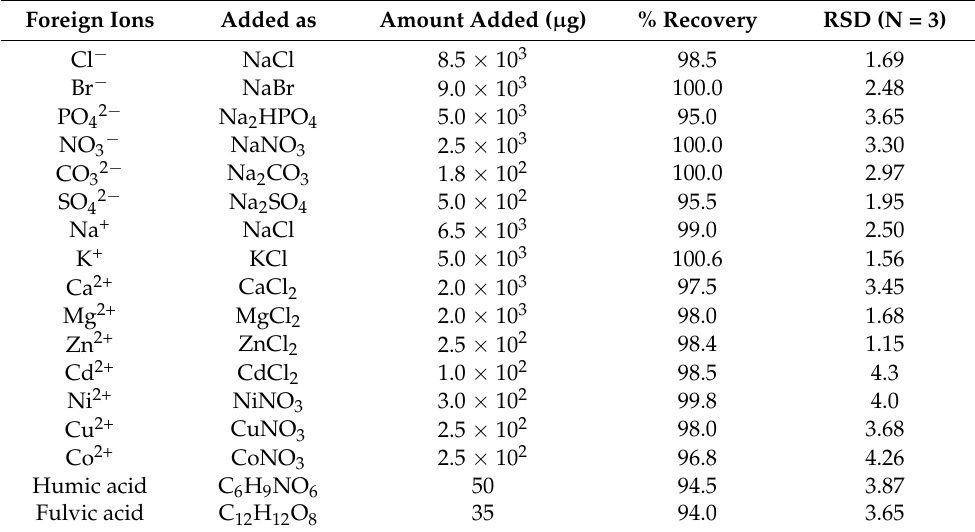
Table 2. Effect of Foreign Ions on the Recovery of